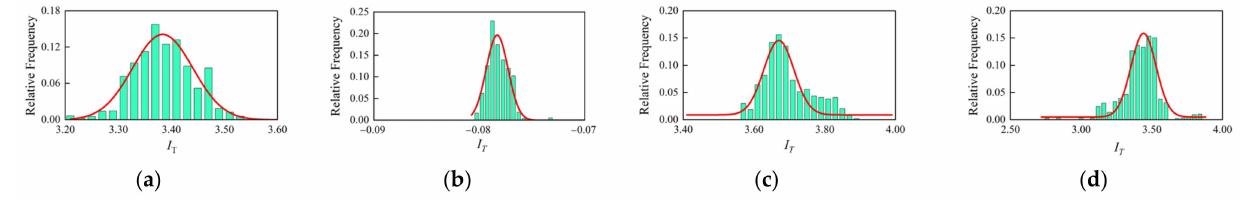
Figure 17. Posteriori relative frequency distribution of member 469. ( a ) Healthy; ( b ) failure of x - directional support restraint; ( c ) failure of y -directional support restraint; ( d ) failure of z -directional support restraint.